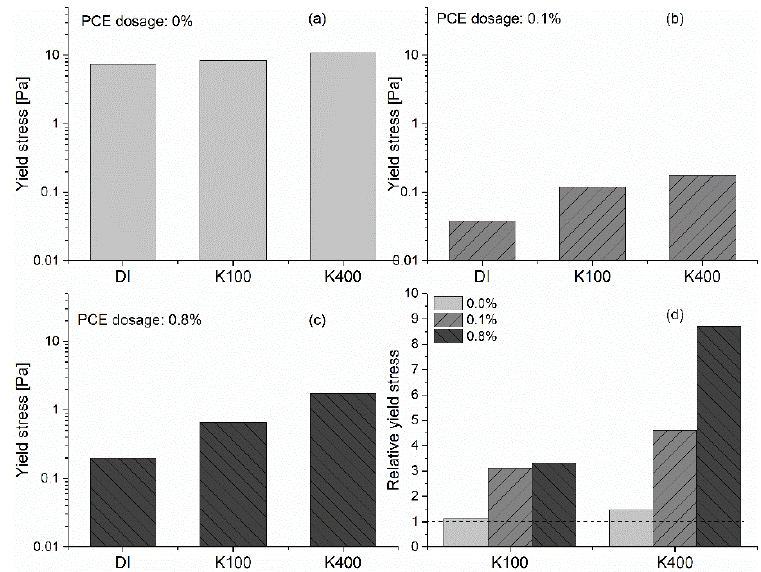
Figure 3. E ff ect of [K + ] on the yield stress of GBS with di ff erent dosages of PCE; ( a ) 0 %; ( b ) 0.1 %; Figure 3. Effect of [K + ] on the yield stress of GBS with different dosages of PCE; ( a ) 0 % ; ( b ) 0.1 % ; ( c ) ( c ) 0.8 %; ( d ) relative yield stress, along with increasing [K + ]. 0.8 % ; ( d ) relative yield stress, along with increasing [K + ].